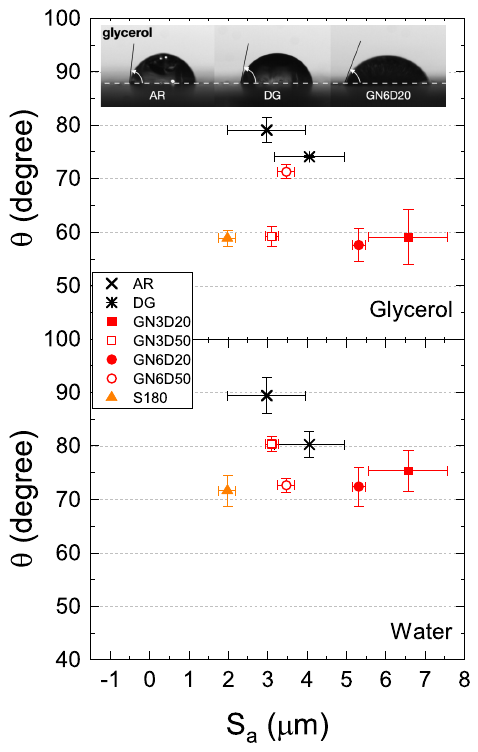
Figure 8. Contact angle as a function of average surface roughness obtained using glycerol and deionized water probe liquids. The insert shows drops of glycerol placed on as-received (AR), degreased (DG), and grit-blasted (GN6D20)